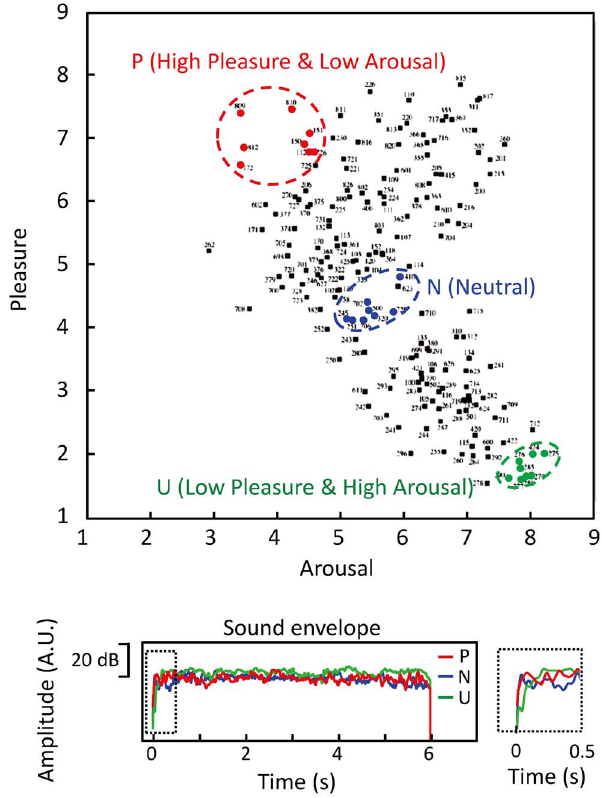
Figure 1. Profile of auditory stimuli. (top) Emotional sounds used as stimuli, shown in the valence and arousal matrix of IADS-2. Sounds used for high pleasant and low arousal (P) category, neutral (N) category, and low pleasant and high arousal (U) category are marked with red, blue, and green dotted lines, respectively. (bottom) Amplitude envelopes averaged over 8 sounds belonging to the same category; whole duration (lower left) and details of the onset (lower right).